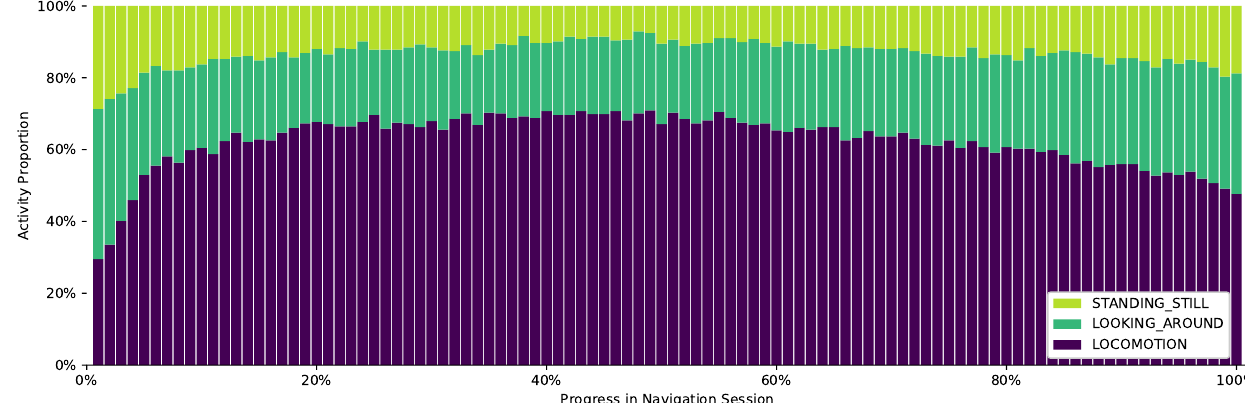
Figure 13. Locomotion and stationary behavior over the time of a navigation